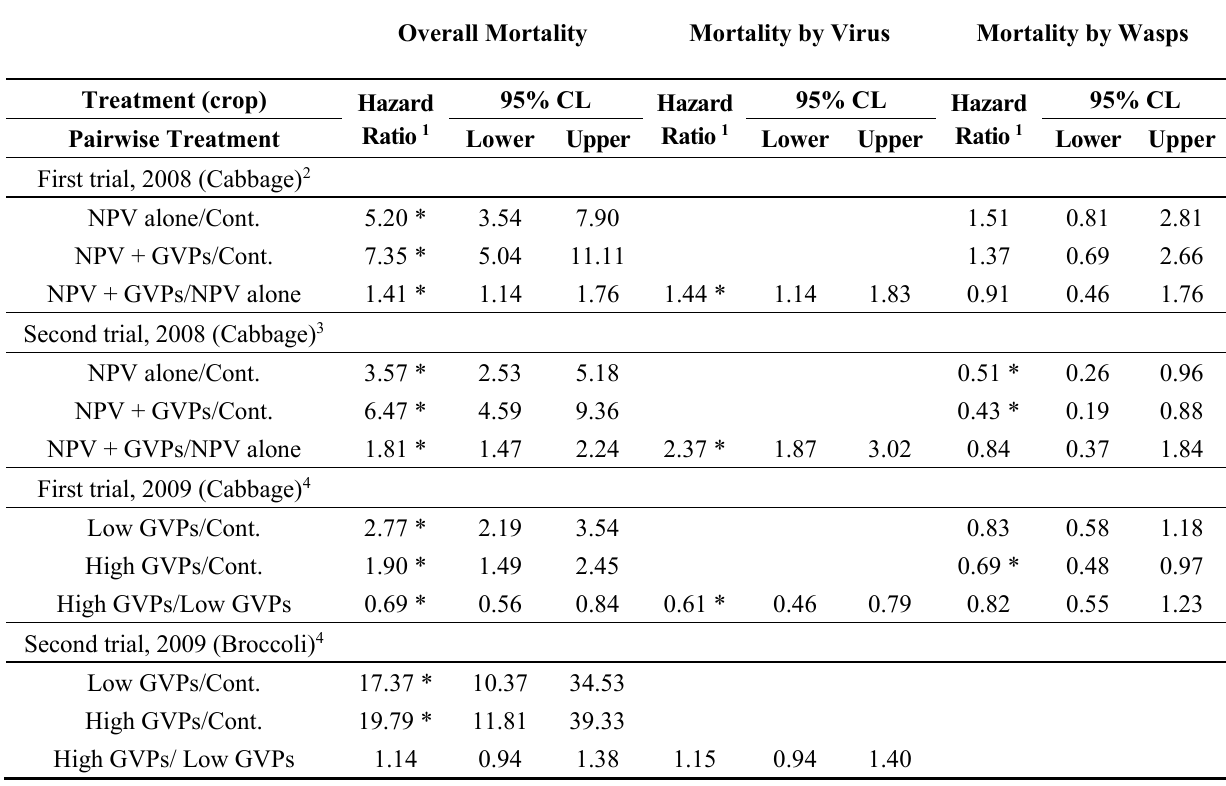
Table 3. The hazard ratios estimated by the CPHA of larvae collected from fields at four days post-application of virus formulations.